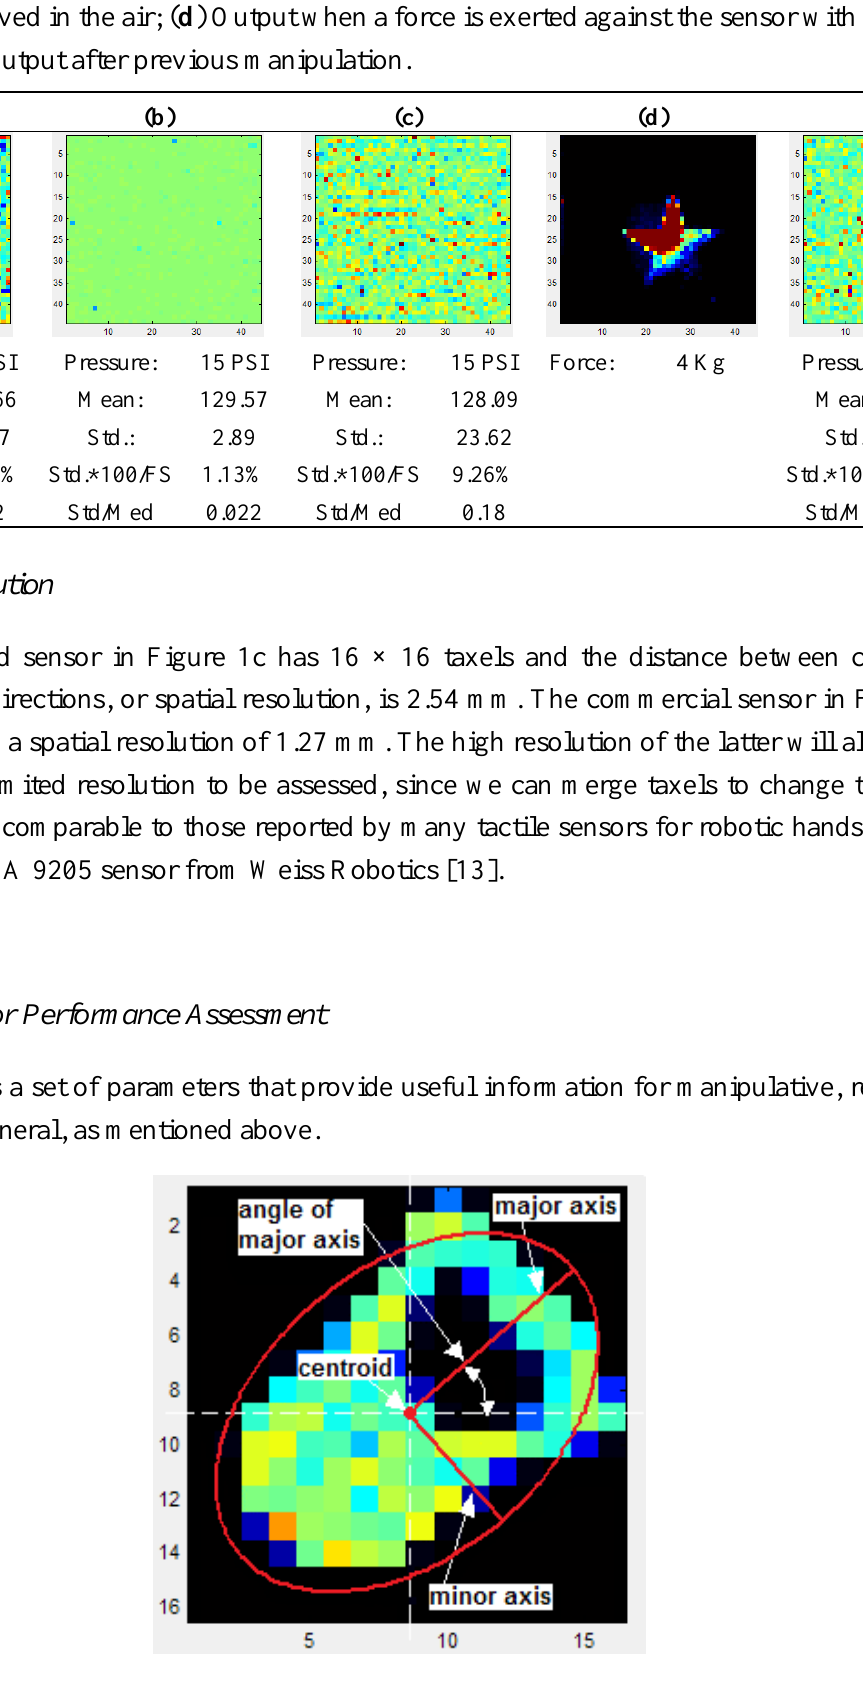
Figure 5. Parameters of the ellipse used to describe the object in manipulation